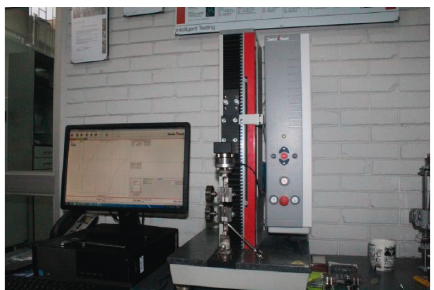
Figure 1: Material testing machine BT1-FR0.5TS.D14 (Zwick GmbH & Co.KG), with which the tensile measurements of all suture materials evaluated were